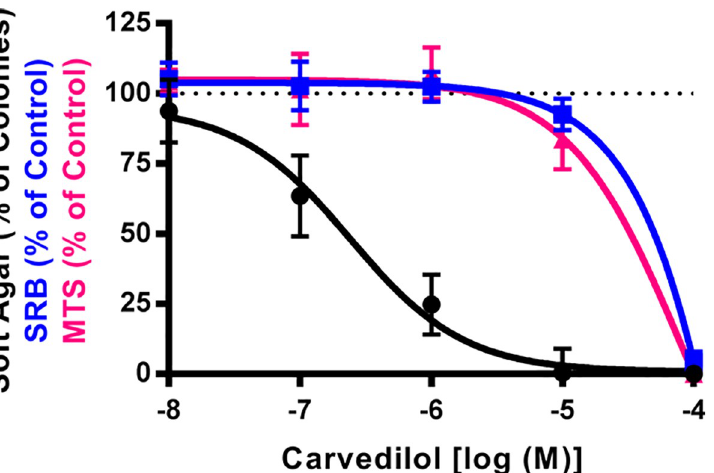
Fig 1. Carvedilol prevented EGF-mediated transformation of JB6 P+ cells independently of its cytotoxic effects. Examination of carvedilol in three assays: 10 μ M EGF-mediated JB6 P+ cell colony formation in soft agar (black) n = 20 to 22, 72-hour SRB cell viability assay (blue) n = 6, and 2-week MTS cell viability assay (pink) n = 6. There is no statistical difference between SRB and MTS assays. Data represented as mean ± SD after normalization to control (EGF minus DMSO control for soft agar, and DMSO for SRB and